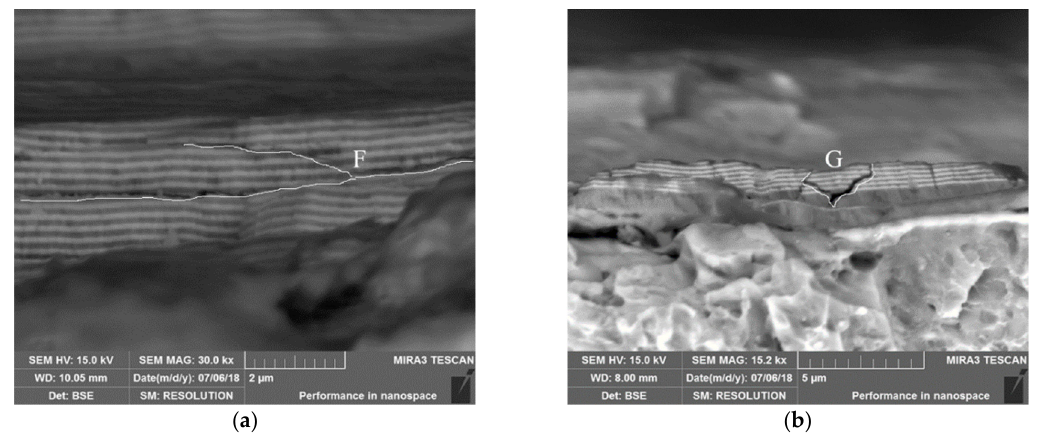
Figure 7. ( a ) Crack deflection and ( b ) crack branching of the TiN/ZrN multilayer coating.